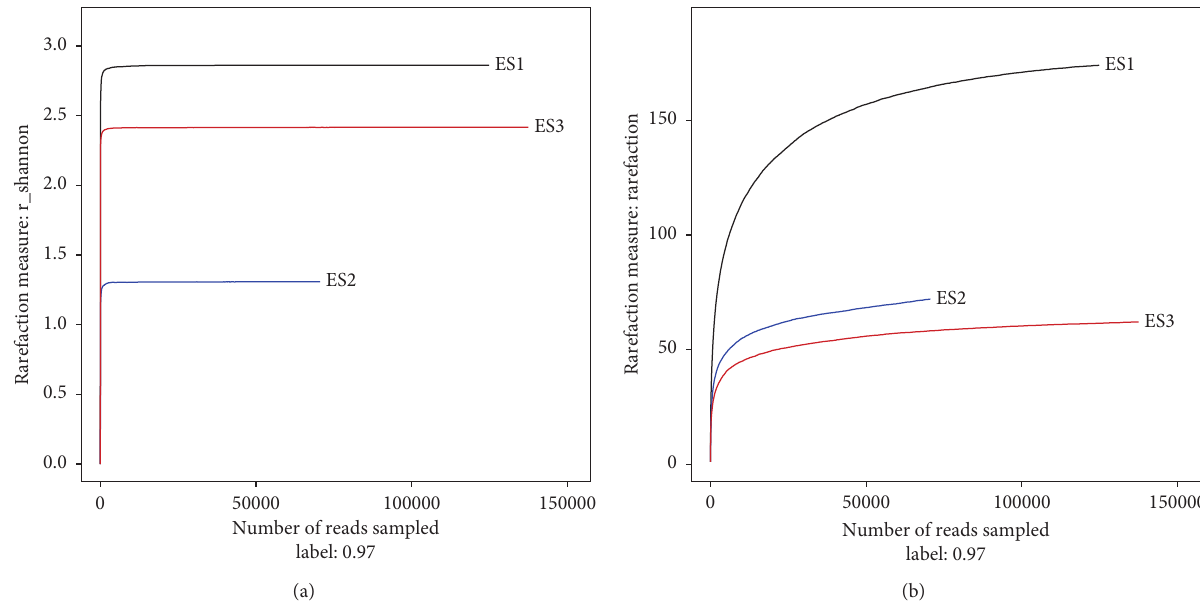
Figure 3: Evaluation of HTS data based on the CaM amplicon. Shannon–Wiener curves show that the fungal diversity levels off with deeper sequencing in all three E. sinensis samples (a). Rarefaction curves show that the abundance of fungal species increased with the number of reads (b).